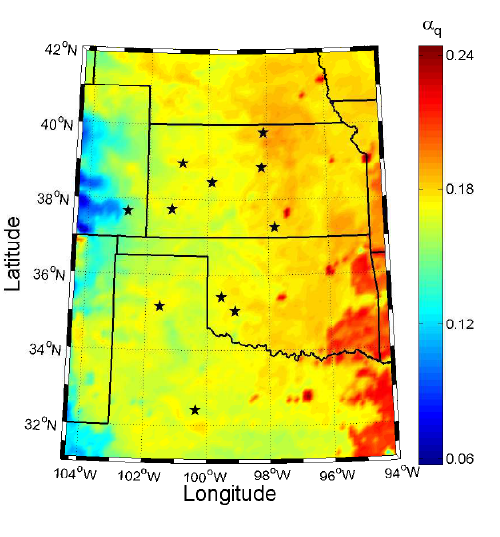
Figure 8. The WRF-NCAR model forecast-derived one-year average shear exponents (left panel) and magnitude of directional shear (right panel). Stars indicate location of tower locations used by SE06. Study period: April 2006–March 2007.